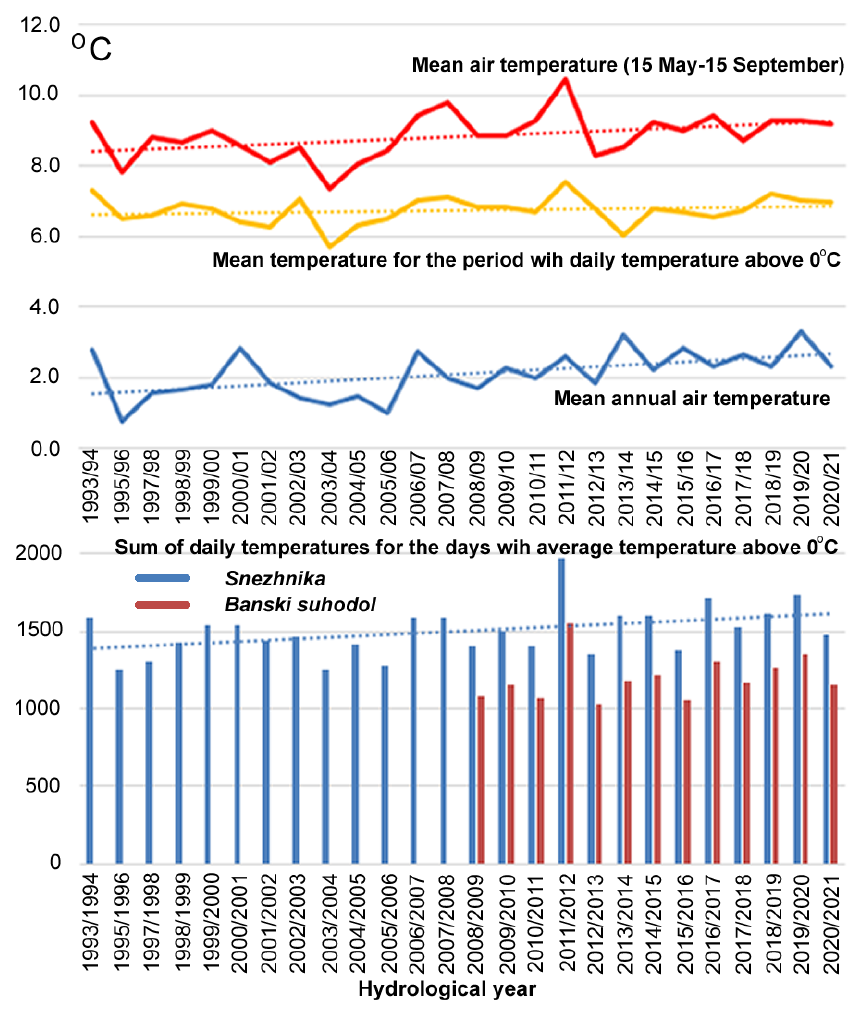
Figure 6. Main variables for air temperature near Snezhnika glacieret derived from meteorological data collected at Musala peak